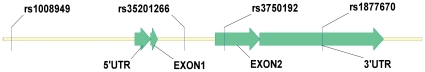
Organization and position of selected SNPs of EGR3.